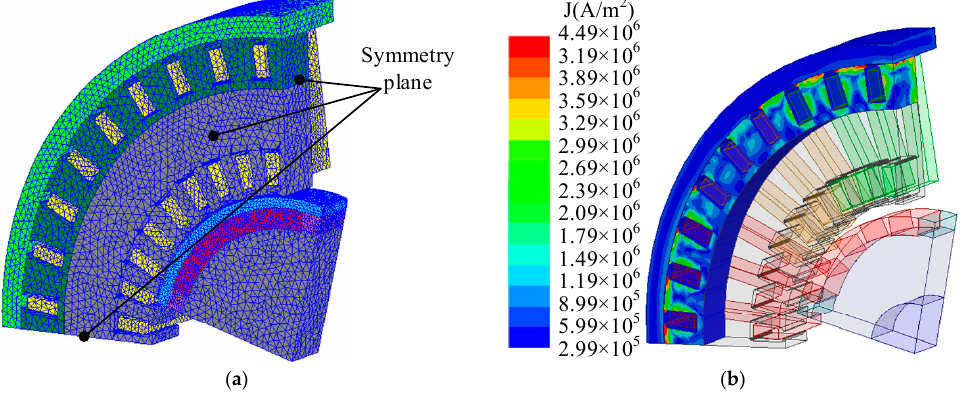
Figure 10. ( a ) 3-d FE mesh model (360,409 tetrahedron element, time step: 5 × 10 − 6 S); ( b ) Distribution of eddy-current density in the shell and outer stator with outer stator material of al-alloy. Table 5. Losses of stator with different materials of outer stator.